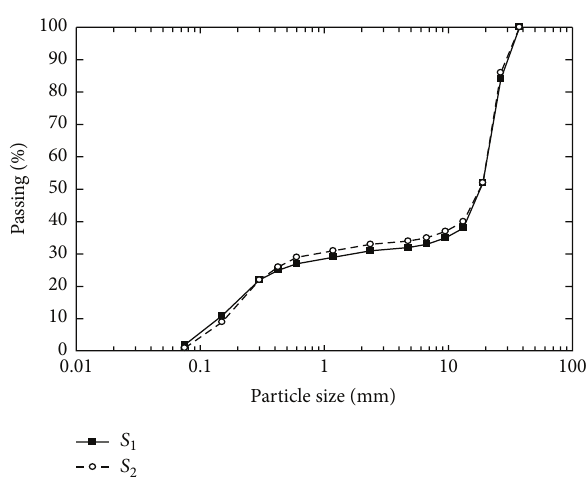
Figure 2: Gradation curves for